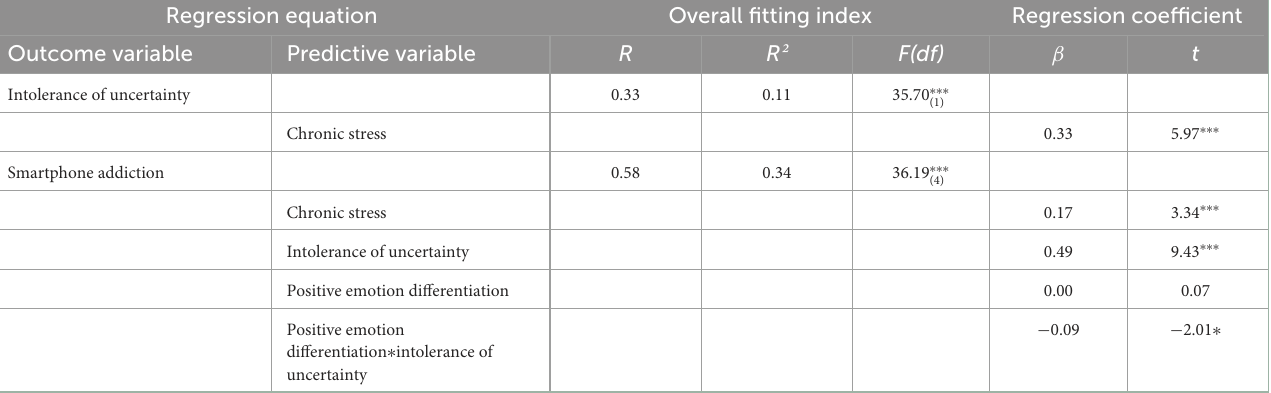
TABLE 4 Moderated mediation analysis.